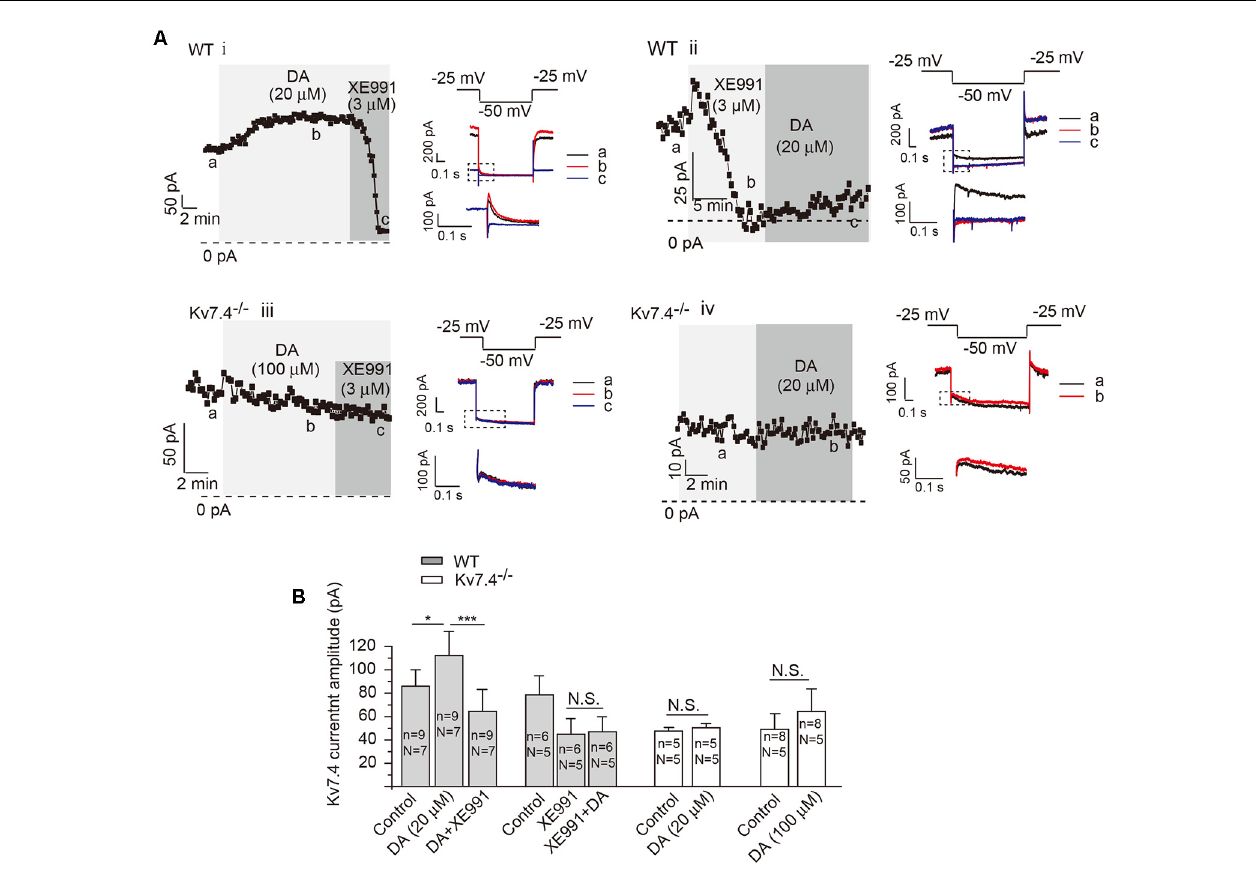
FIGURE 2 | Dopamine activates Kv7/M current in NAc-projecting VTA DA neurons. (A) Kv7/M currents recorded from DA neurons of WT (i,ii) and Kv7.4 − / − (iii,iv) mice. Shown are time-courses of M current amplitudes recorded using whole-cell patch-clamp from VTA slices (for details, see “Materials and Methods” section). Summarized data are presented in (B) . Error bars represent SEM. ∗∗∗ p < 0.001, ∗ p < 0.05; N.S., not significant. One-way repeated-measures ANOVA with Bonferroni test for WT mice, paired t -test for Kv7.4 − / − mice. N = number of animals; n , number of recordings.